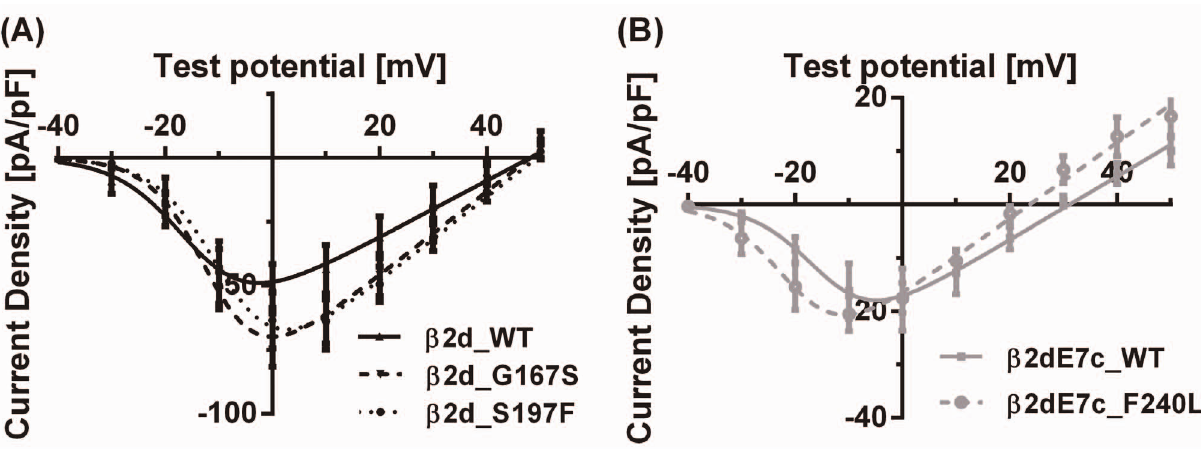
Figure 3. I–V relationships. Currents were elicited from 2 40 to + 60 mV in 10 mV increments with 5 mM or 20 mM Ba 2 + , respectively. The holding potential was 2 100 mV. Current density of the variants p.G167S (N=11) and p.S197F (N=8) in ( a ) and p.F240L (N=5) in ( b ) were compared with their respective WTs ( b 2d_WT: N=9 and b 2dE7c_WT: N=5).